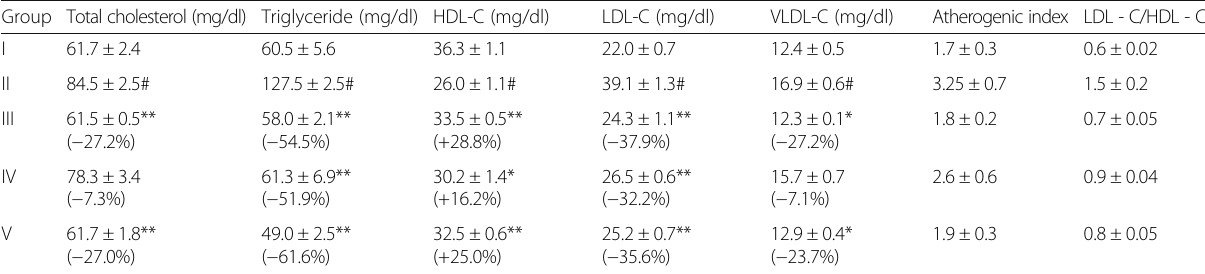
Table 8 Effect of C. azarolus var. eu- azarolus leaves extract on serum lipid profile, Atherogenic Index and LDL-C/HDL-C ratio in hyperlipidemic rats in hyperlipidemic rats (values are represented as Mean ± SEM) Group Total cholesterol (mg/dl) Triglyceride (mg/dl) HDL-C (mg/dl) LDL-C